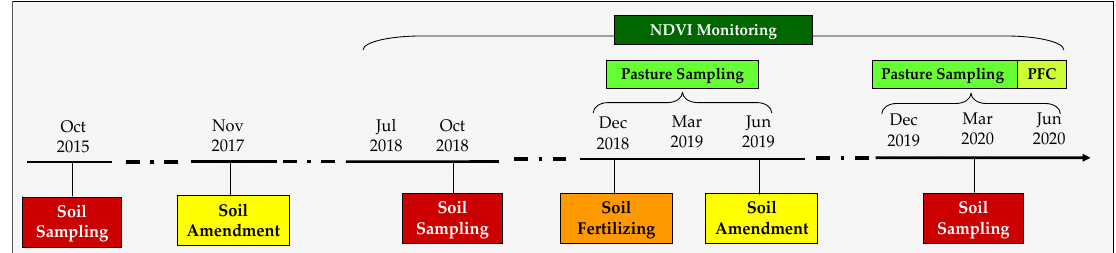
Figure 3. Chronological sequence of the interventions and measurements in the experimental field between October 2015 and June 2020. PFC—Evaluation of pasture floristic composition.